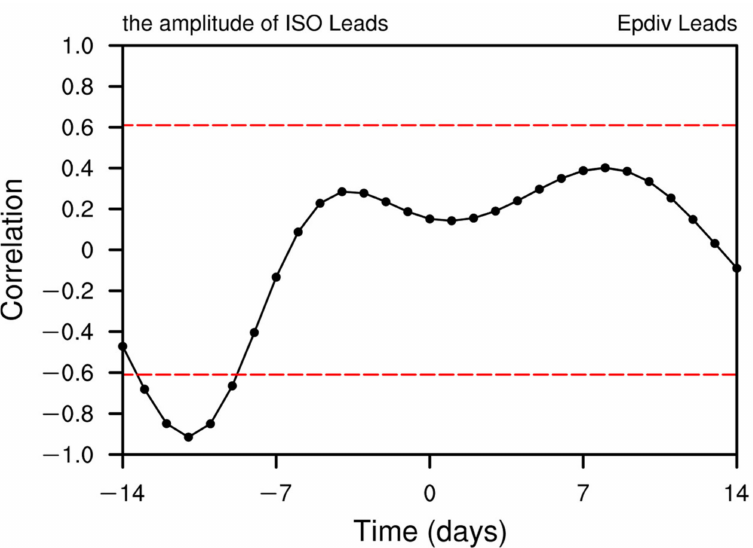
Figure 8. The lead–lag correlation coefficients between the amplitude of mid-high-latitude ISO (PC) and EP flux divergence (EPdiv) over about 1 month centered on the onset day of the 2018 SSW event. EPdiv is averaged from 50 ◦ to 80 ◦ N, from 10 to 100 hPa. The red dashed lines represent the 0.05 significant level in accordance with two-tailed Student’s t -test. The negative (positive) days denote that the amplitude of ISO leads (lags)